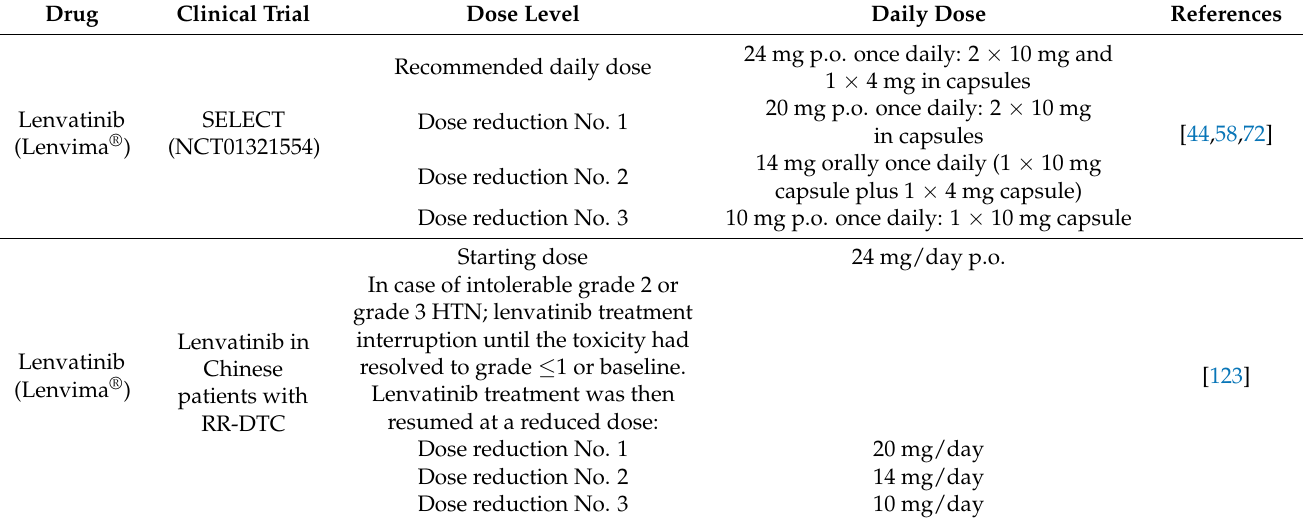
Table 7. Hypertension management in clinical trials. Dose modifications for